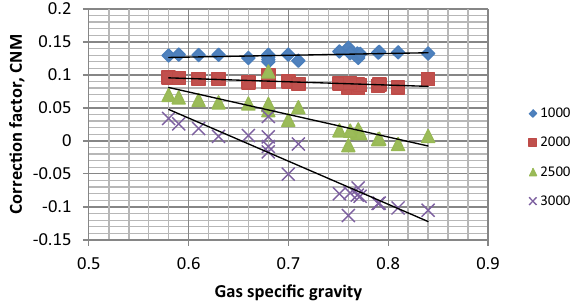
Fig. 4 Calculation of C NM at 160 (cid:3) F and different